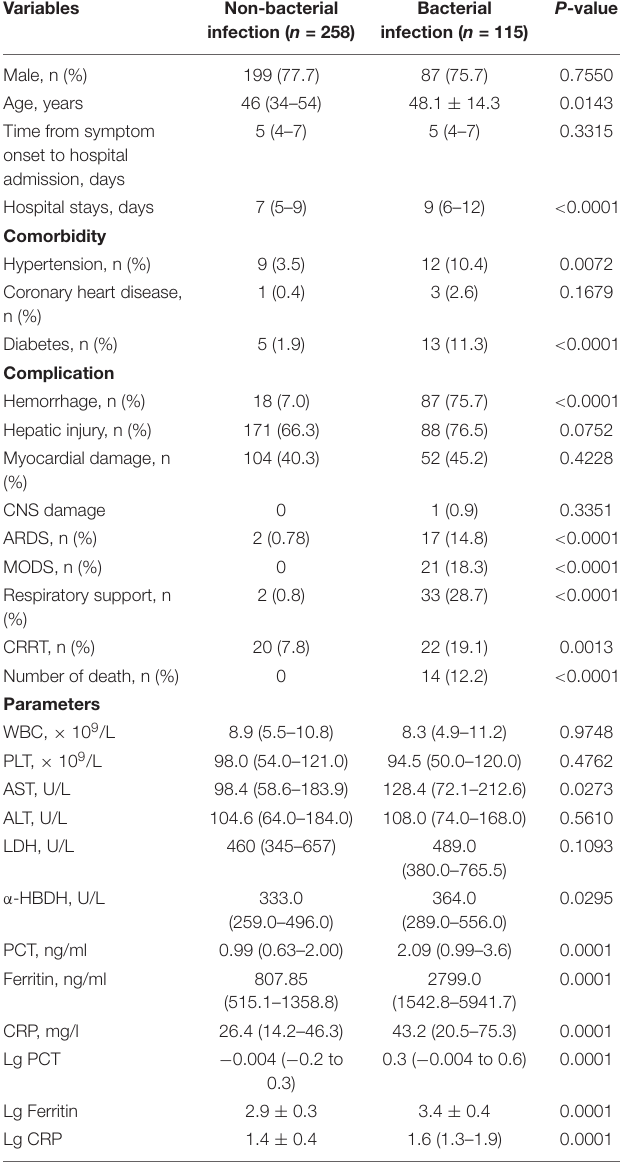
TABLE 4 | Demographics and clinical and laboratory data at admission in the patients with and without bacterial infection*.